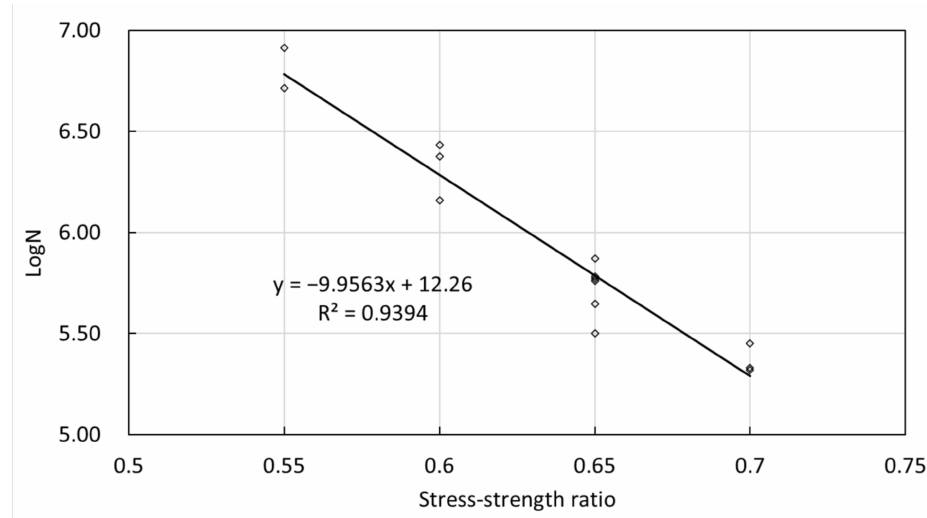
Figure 11. Fitting curves of CSG fatigue test in different stress–strength ratios. Table 8. Mixture design of LFSG and CSG.